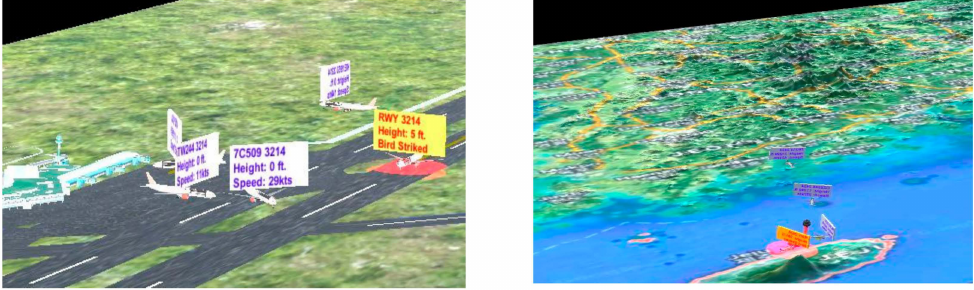
Figure 7. The red light over the airplane in emergency